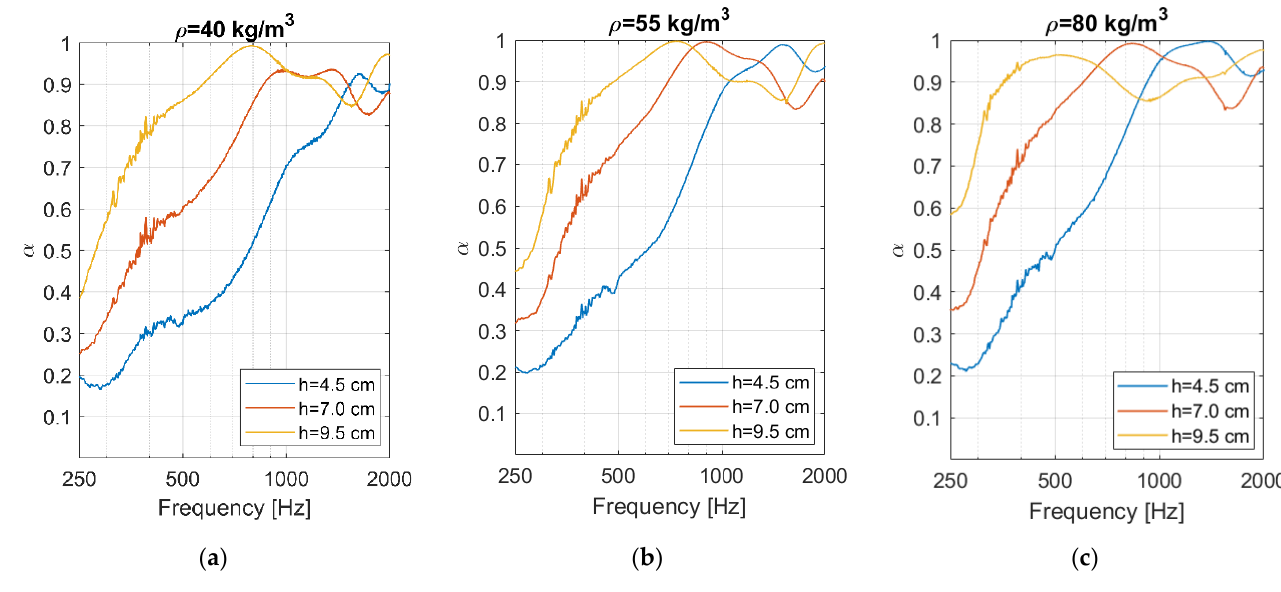
Figure 6. The measured sound absorption coefficients (average of 3 measurements).